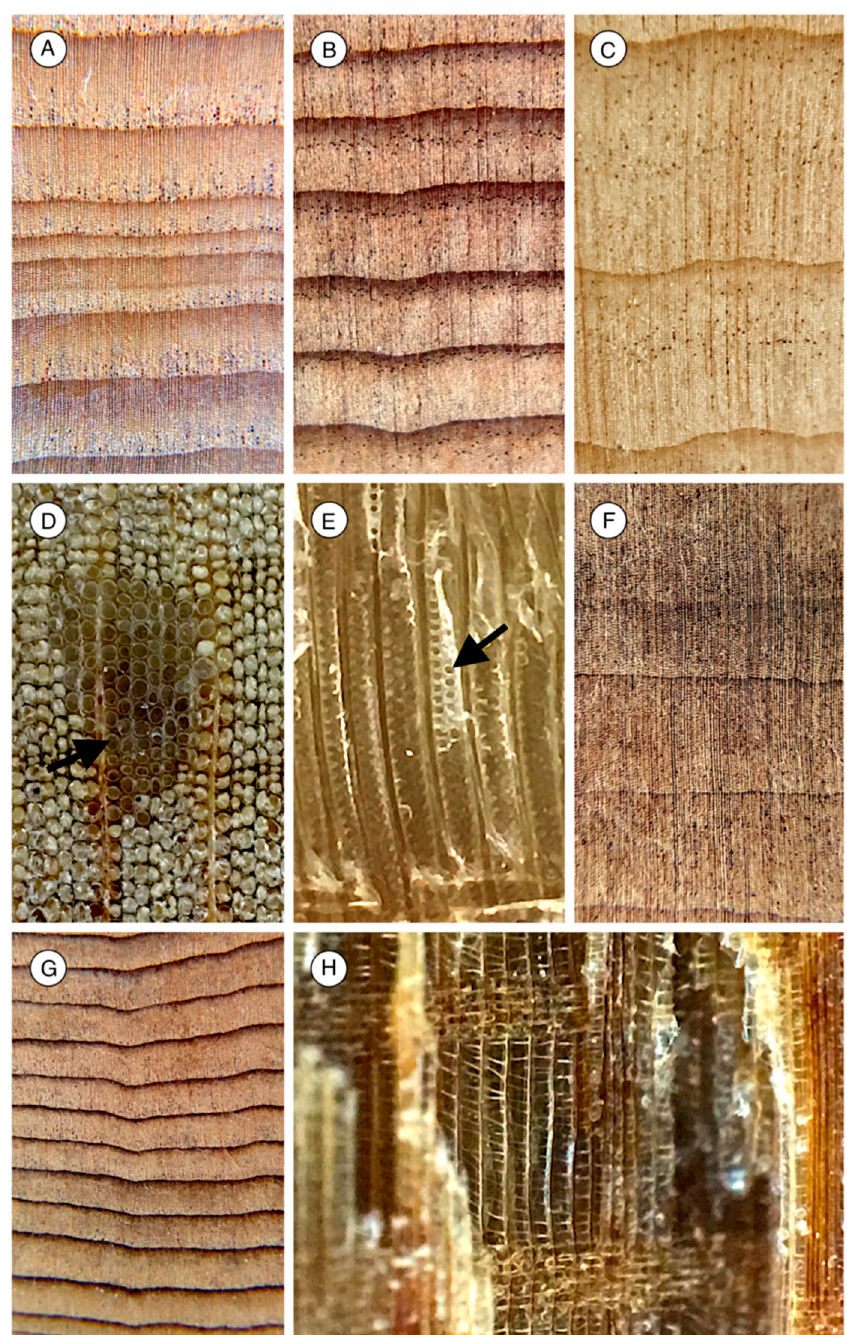
Figure 3. Elements visible with 24× and 400× lenses in softwoods. ( A ) Growth rings in Abies guatemalensis (24× lens). ( B ) Tangentially zonate axial parenchyma in Fitzroya cupressoides (Molina) I.M.Johnston (24× lens). ( C ) Diffuse axial parenchyma in Pilgerodendron uviferum (D.Don) Florin (24× lens). Araucaria araucana (Mol.) K.Koch. ( D ) Organic deposits in axial tracheids (400 × lens). ( E ) Alternate polygonal pits in axial tracheids (400 × lens). ( F ) Di ff use axial parenchyma in Podocarpus neriifolius D.Don (24 × lens). Taxus cuspidate Siebold and Zucc. ( G ) Growth rings (24 × lens). ( H ) Helical thickenings in axial tracheids (400 ×